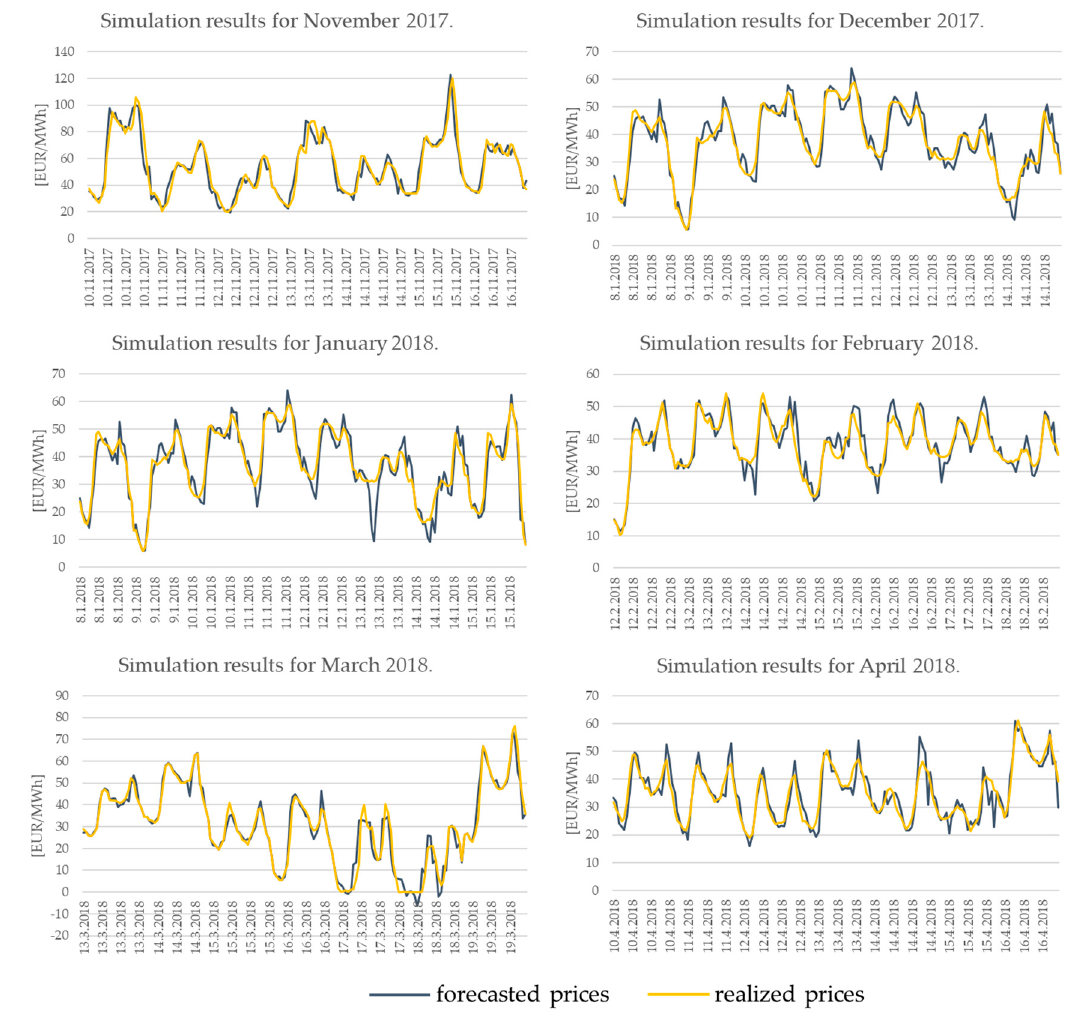
Figure 19 . Forecasted and actually realized hourly prices in second forecasting interval for period November 2017 to April from November 2017 to April 2018.